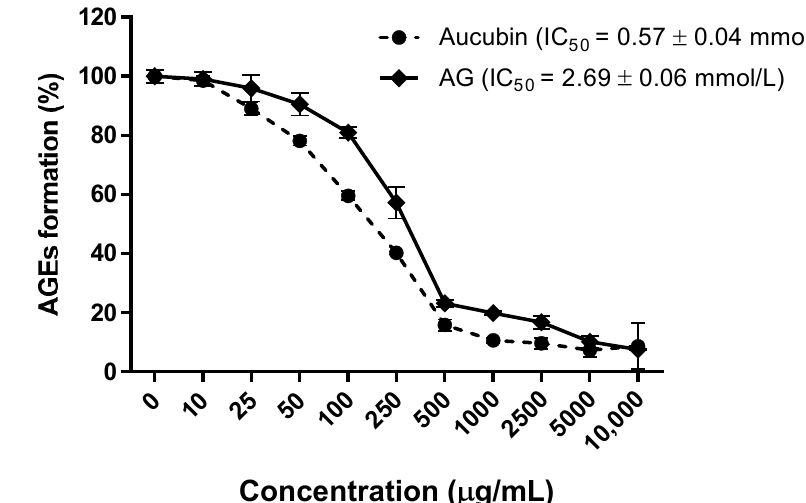
Figure 1. Inhibitory effect of aucubin and AG on the formation of methylglyoxal (MGO)-derived advanced glycation end products (AGEs) in vitro. All results are expressed as the mean ± SE, n = 4. The IC 50 values were determined from the plotted graph.